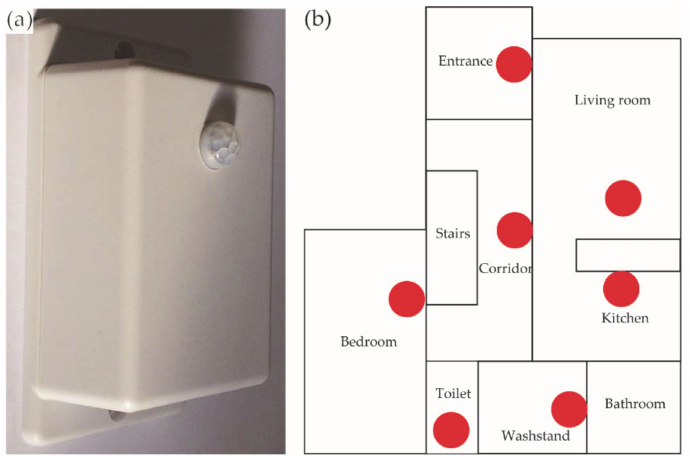
Figure 4. Infrared sensor and installation drawing. ( a ) Infrared sensors (HIRO ICT Inc.; L90.0 × W50.0 × D30.0 mm) were used to evaluate the daily activity of older people. ( b ) Example of the sensor installation. Red dots represent the points where the sensors were